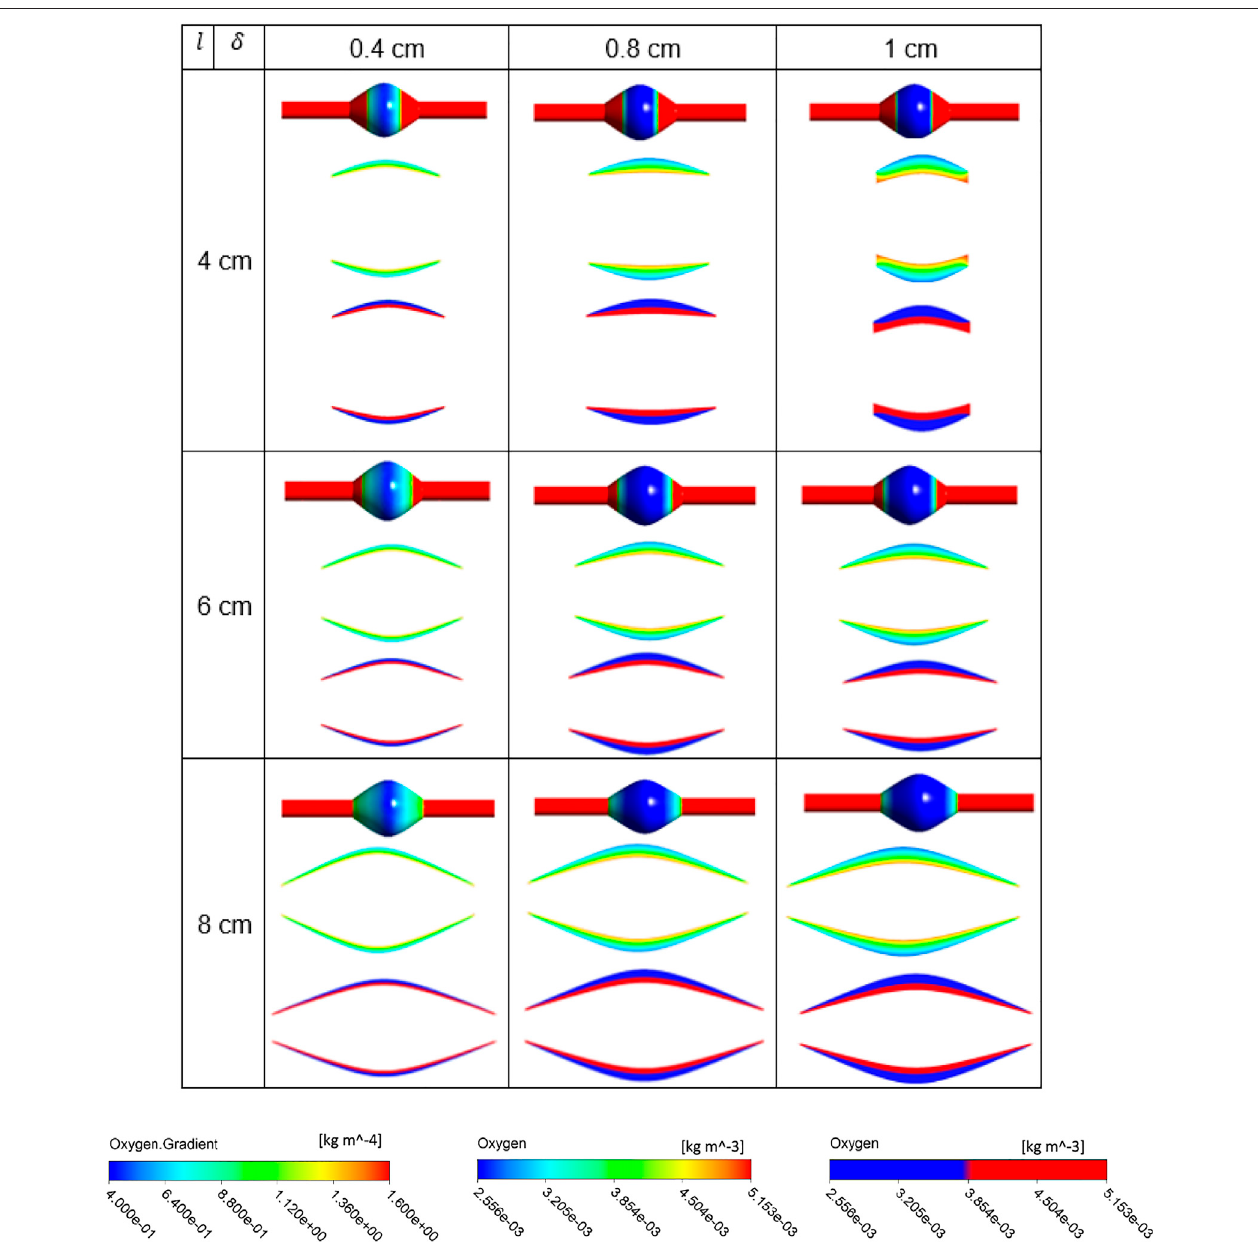
FIGURE 9 | Results of different combination of design variables ILT length ( l ) and ILT thickness ( δ ), with bulge diameter being fi xed as BD = 7 cm. Each cell corresponds to the results for one case of the nine different AAA geometries provided in Figure 2 . In each cell, three oxygen measures are plotted from top to bottom: contourofoxygen fl uxontheabluminalsurfaceofthearterialwallforallanalyzedcasesonthesamescale,contourplotofoxygenconcentrationinILTonthesamescale, and fi nally oxygen value using a two-bands color scale ranging from abluminal oxygen concentration 2.56 × 10 − 3 kg/m 3 (blue) to ≥ 75% C in f kg/m 3 (red). Scales on the bottom are used for displaying